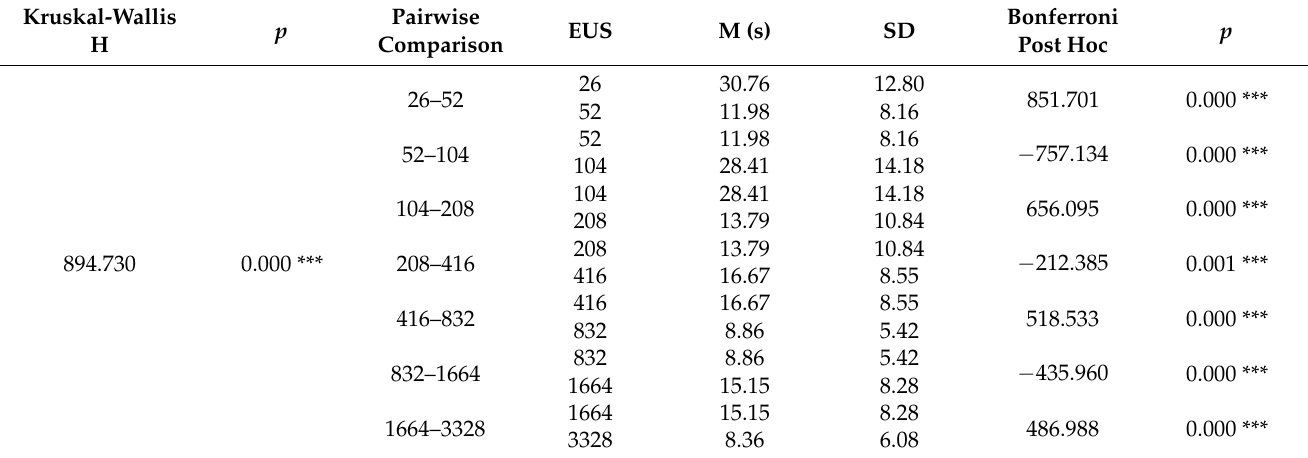
Table 5. The pairwise comparison of the answer times for task 3, *** p ≤ 0.001. Kruskal-Wallis